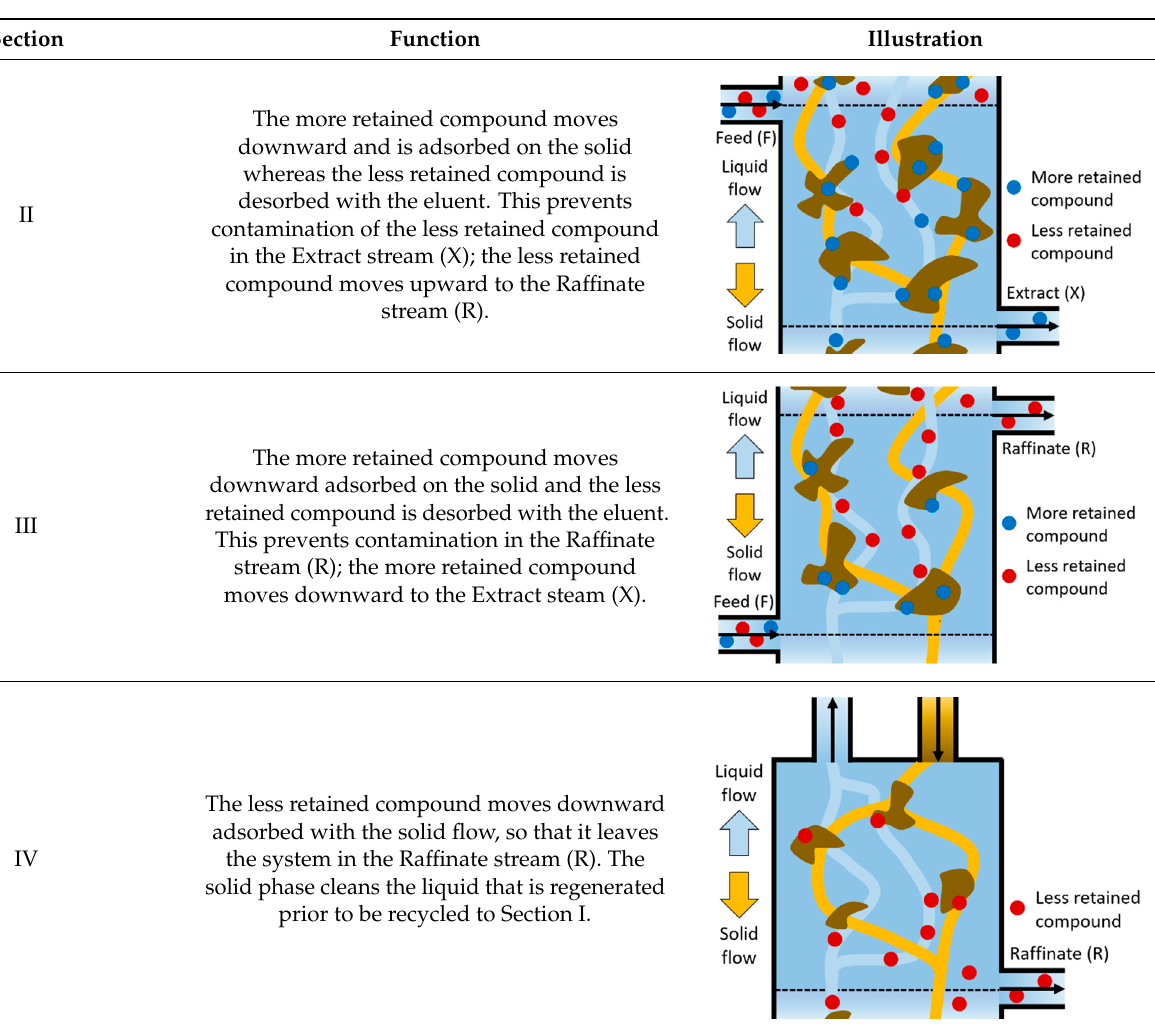
Table 11. Experimental studies of enantioresolutions applying SMB chromatography.